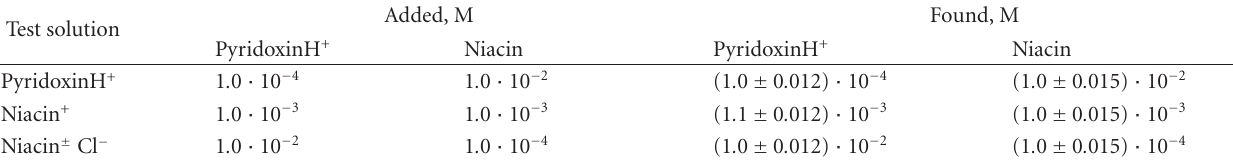
Table 5: The actual and measured values of the analyte concentrations for some test solutions PyridoxinHCl + Niacin. Added, Test solution